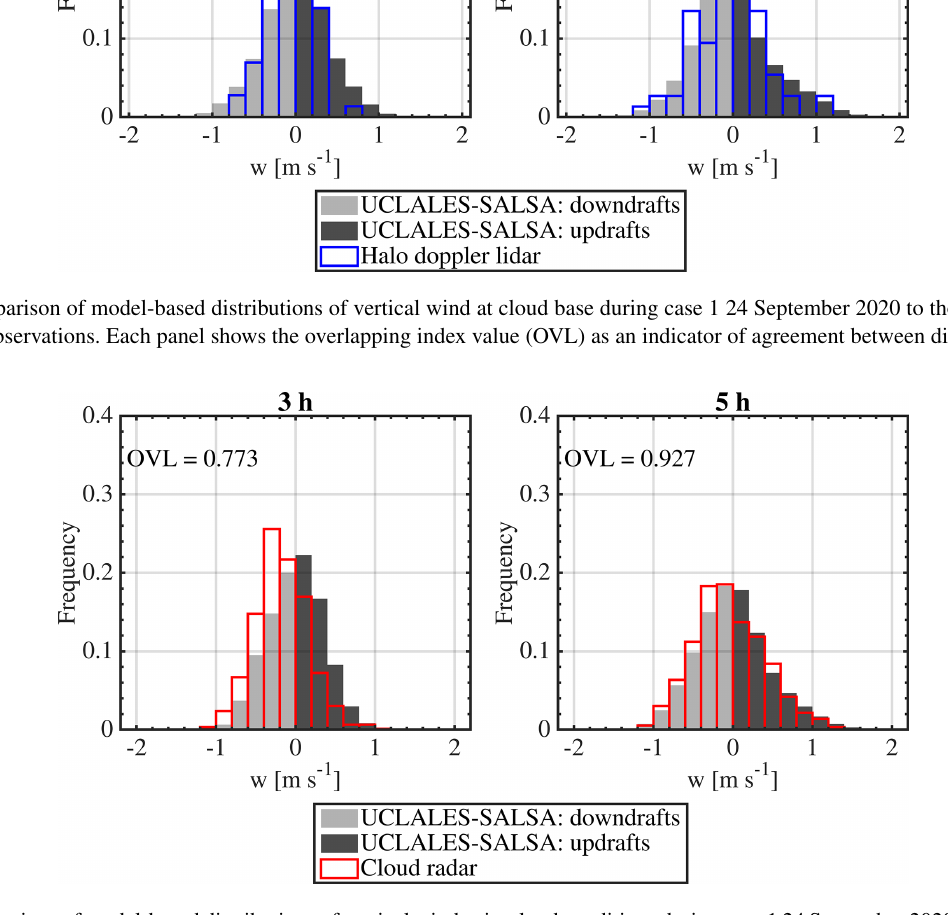
Figure 5. Comparison of model-based distributions of vertical wind at in-cloud conditions during case 1 24 September 2020 to those retrieved from cloud radar observations. Each panel shows the overlapping index value (OVL) as an indicator of agreement between